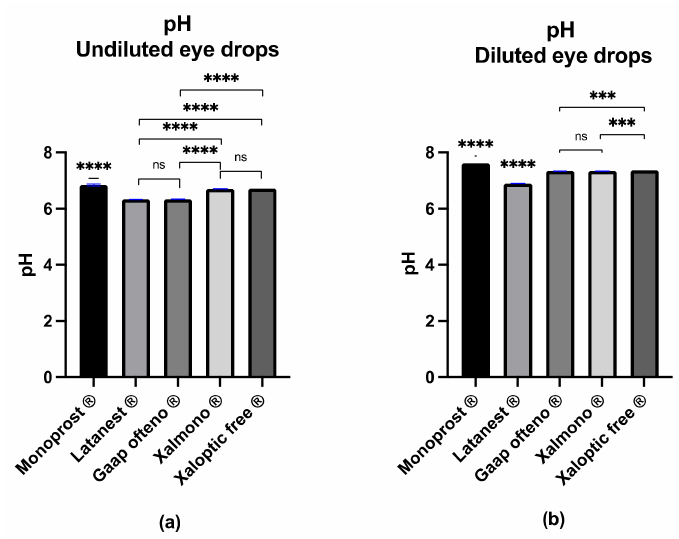
Figure 1. The pH value characterization of preservative-free 0.005% latanoprost products Monoprost ® , Latanest ® , Gaap Ofteno ® , Xalmono ® , and Xaloptic ® Free: ( a ) pH value of the undiluted eye drops; ( b ) pH value of the diluted eye drops (1:7, v / v ). Values are listed as mean ± SD, and n = 3. A one-way ANOVA with a Tukey multiple-comparison test ( p = 0.05) was performed. ns = not significant, with p ≥ 0.05, *** p ≤ 0.001, **** p ≤ 0.0001.